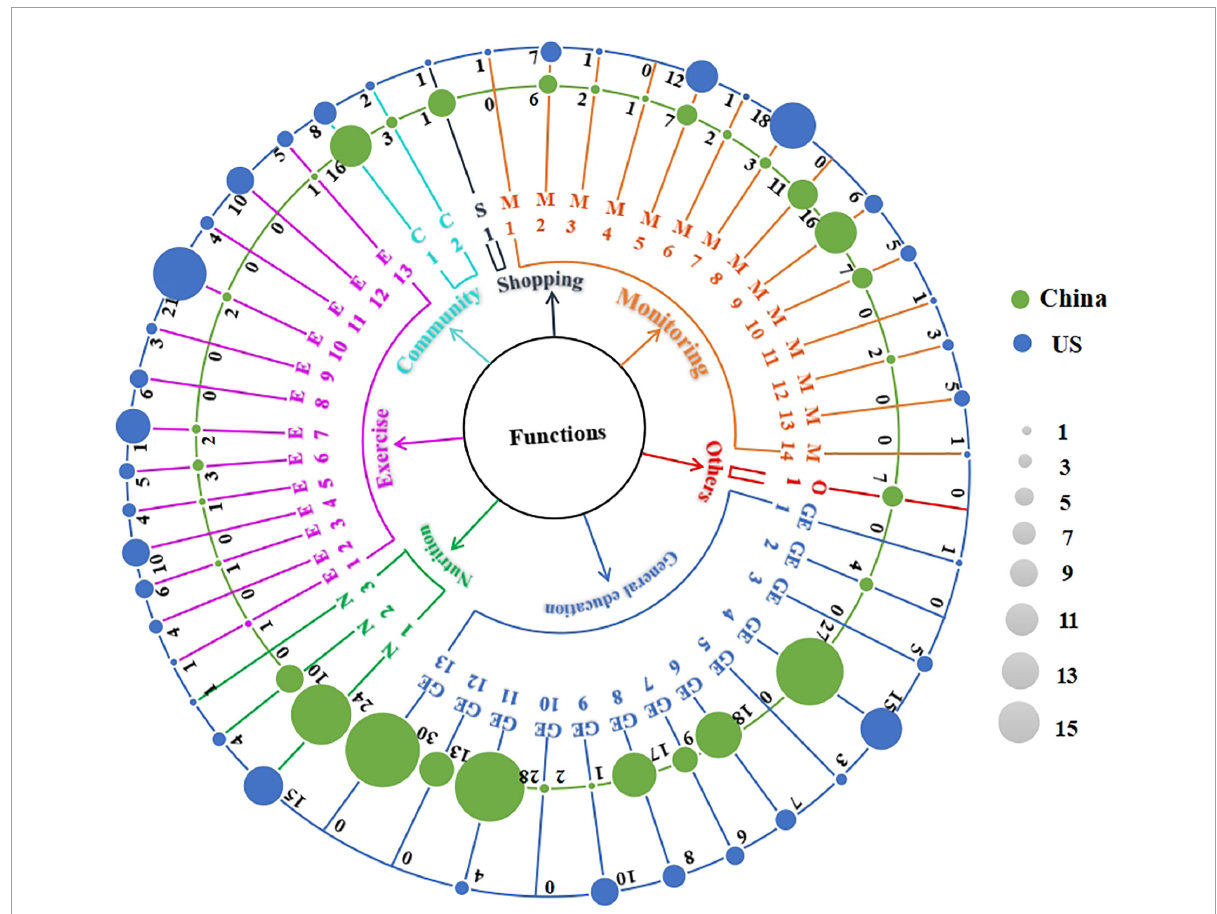
FIGURE3 The bubble chart compares the secondary models of 34 Chinese and 31 United States-based mobile apps for prenatal to postnatal nutrition and physical activity. Abbreviations used in this figure are detailed in Figure 2